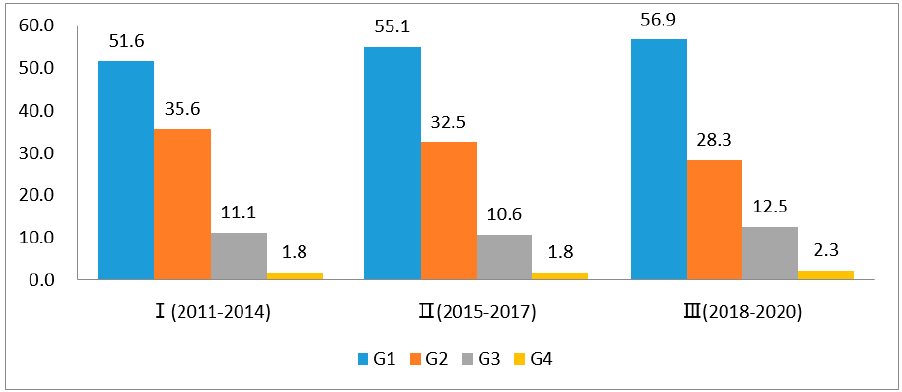
Figure 4. Characteristics of digital oil field (DOF) development by time series.